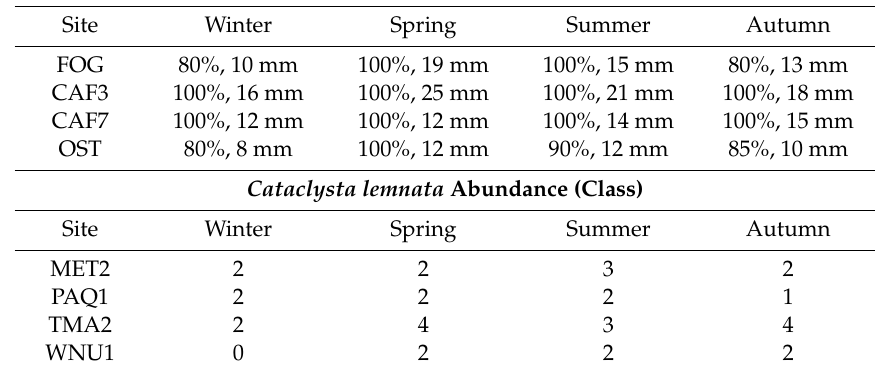
Table 1. Phenological monitoring of populations of L. minuta and C. lemnata in a site-subset during di ff erent seasons. Site acronyms: FOG = Foglino wood; CAF 3, CAF 7 = Ca ff arella Valley; OST = Ostia Lido; MET 2 = Metaponto; PAQ 1 = Aqueduct Park; TMA 2 = Tor Marancia Park; WNU 1 = Water